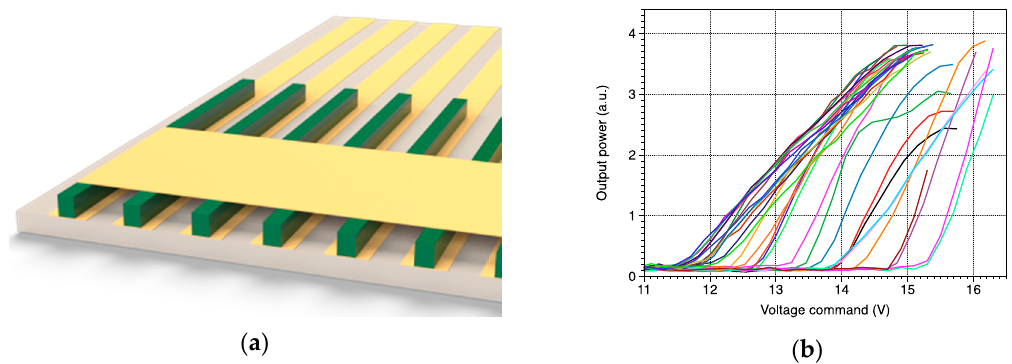
Figure 2. ( a ) Schematics of the DFB QCL array. The electrical contact (in yellow) of the DFB QCLs (in green) is given by a gold common terminal and by gold individual tracks under the lasers; ( b ) Power of the 34 QCLs of the array vs. voltage command. Supply conditions of all pulsed lasers are: temperature 20 °C, pulse duration 100 ns, repetition rate 100 kHz, peak current 1.3 A.